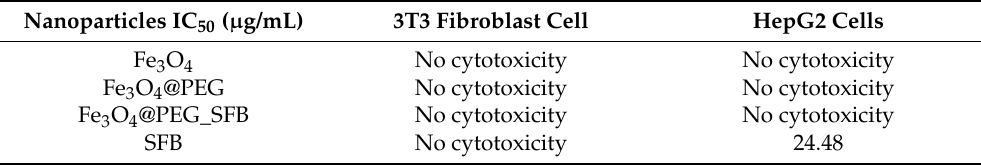
Table 1. IC 50 value (the half-maximal inhibitory concentration) for Fe 3 O 4 , free SFB, Fe 3 O 4 @PEG, and Fe 3 O 4 @PEG_SFB samples tested on 3T3 and HepG2 cell